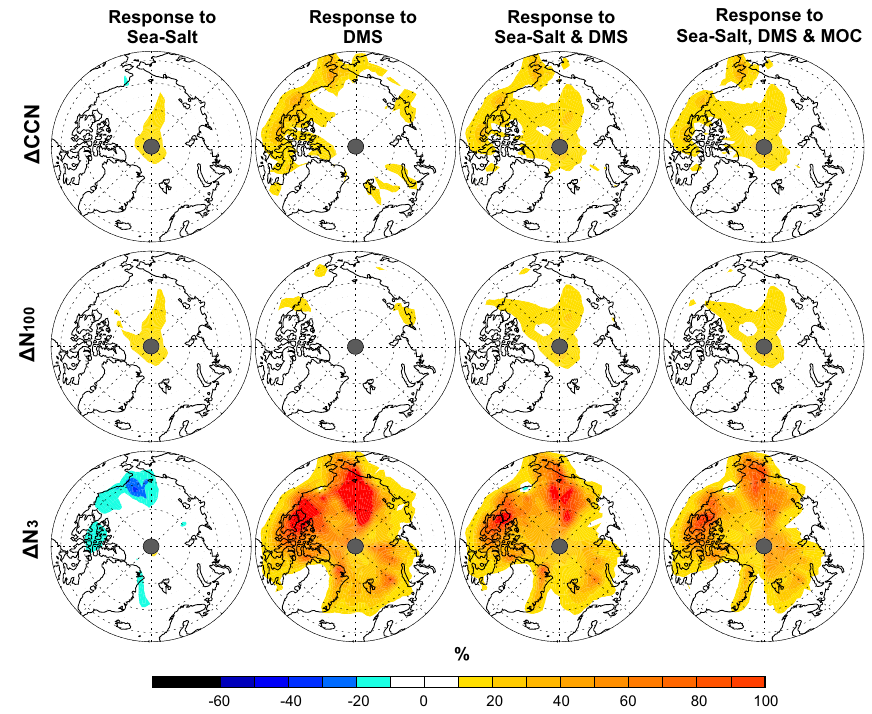
Figure 6. Response of modelled surface level aerosol concentrations due to complete loss of sea ice in a model run without drizzle: CCN (top), N 100 (middle) and N 3 (bottom). Different aerosols and precursors are allowed to respond to the ice loss: sea-salt flux (column 1), DMS flux (column 2), sea-salt and DMS flux combined (column 3) and all aerosol (sea-salt, DMS and marine organic carbon flux) (column 4). A. Mean Surface Size Distribution (where CCN # )decrease